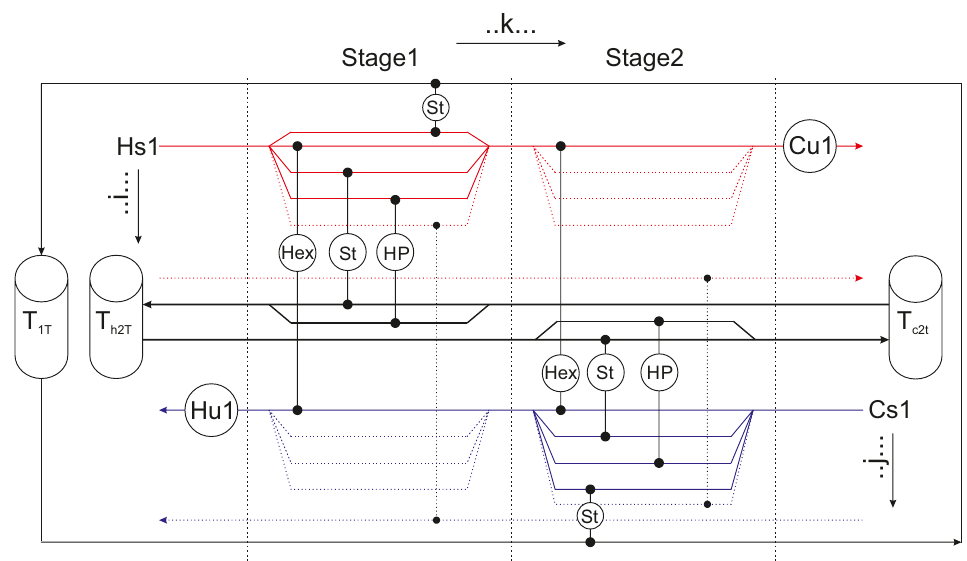
Figure 1. “Superstructure with possible Stream-Stream Hex (HEX), Stream-Storage Hex (ST) and Heat Pumps (HP)” from Prendl et al. [3]/CC BY